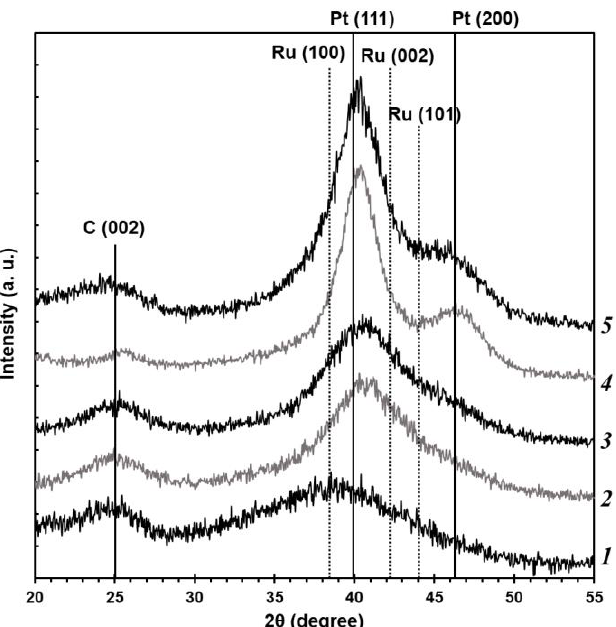
Figure 1. The X-ray diffraction patterns of the PtRu/C catalysts. 1 — BHA; 2 — PtRu-AA; 3 — BH; 4 — BHC; 5 — P.